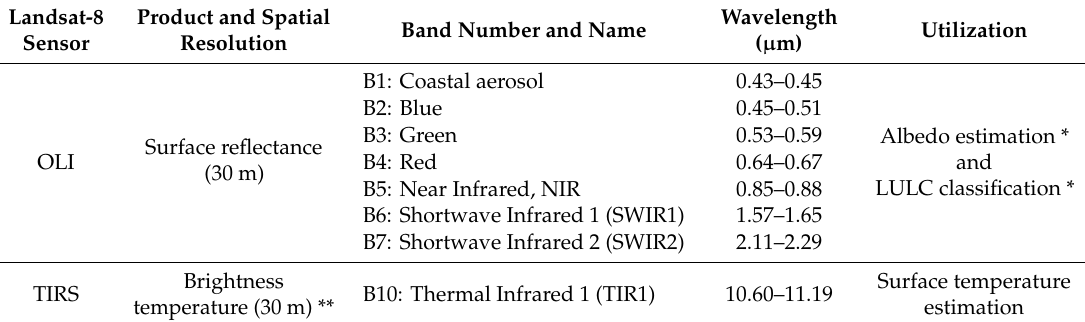
Table 2. Characteristics of the Landsat-8 images used in this study, and its